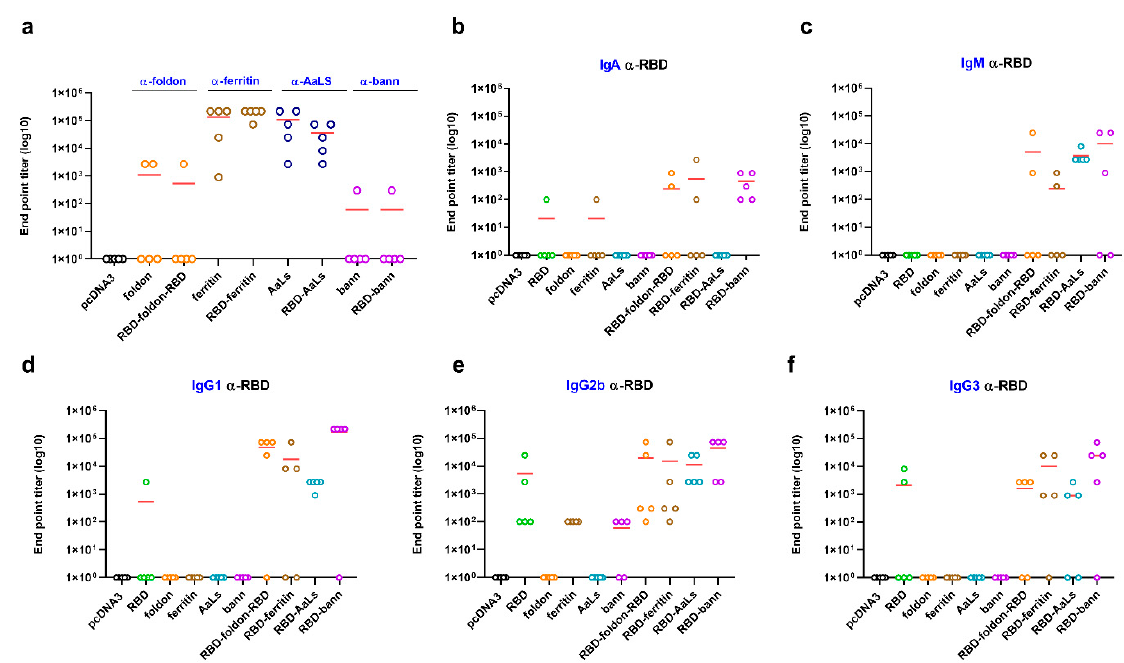
Figure 2. Antibody response depending on the nanoscaffolding domain and Th-1 biased antibody response in vivo. Mice were immunized with the indicated plasmid DNA coding for scaffolds or RBD variants, and end point titers of total IgGs against different scaffold molecules were measured with ELISA ( a ). End point titers of different isotypes (IgA ( b ) and IgM ( c )) and subclasses (IgG1 ( d ), IgG2b ( e ), and IgG3 ( f )) of immunoglobulins against RBD were determined by ELISA six weeks after the first immunization. Graphs represent the mean EPT of groups of mice ( n = 5 per group). Each dot represents an individual animal.